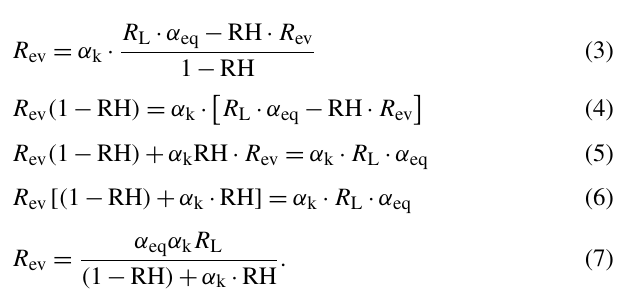
At ∼ 63 ◦ S, change from westerlies to polar easterlies is